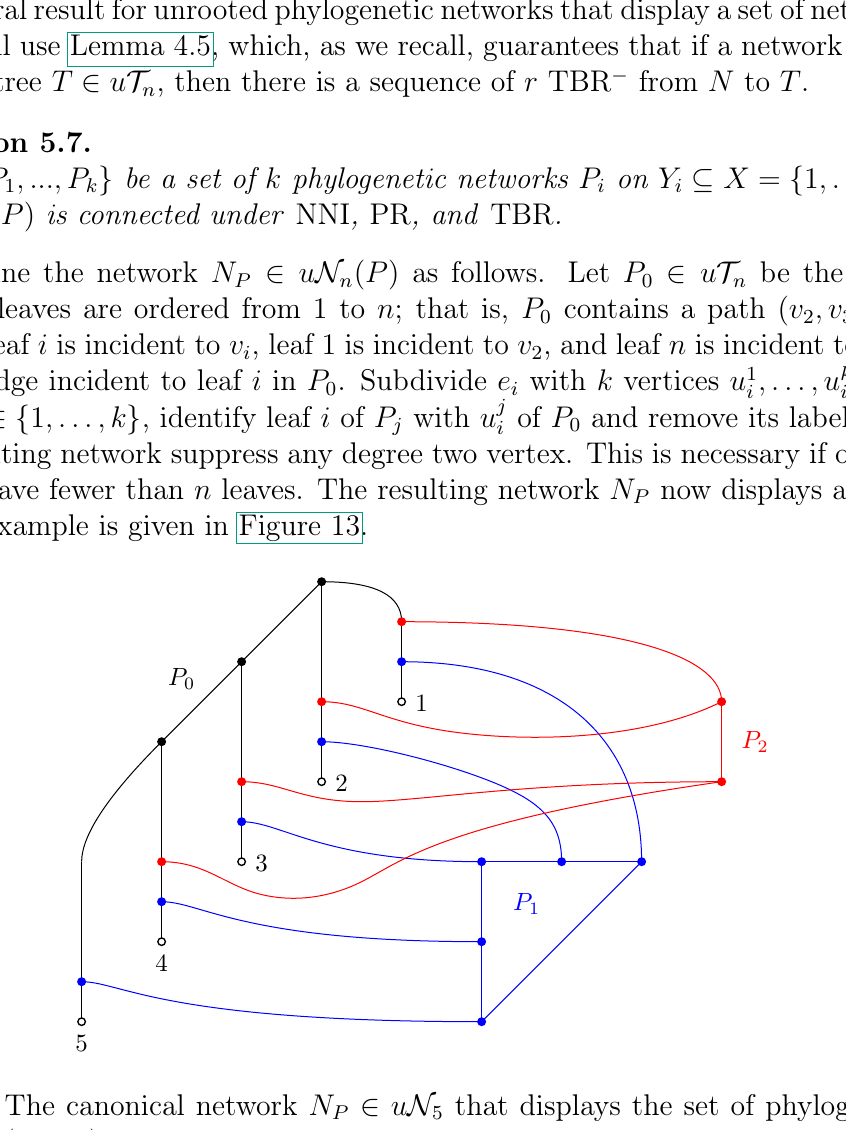
, P ) with the underlying caterpillar P 1 2